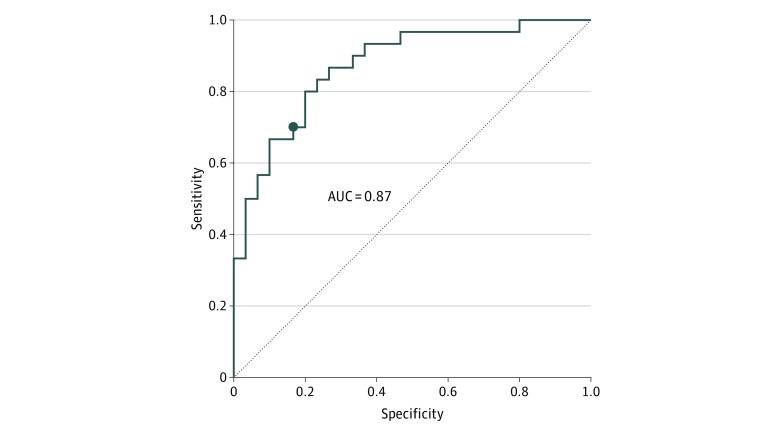
Receiver Operating Characteristic Curve Showing Classification Model PerformanceModel quality is demonstrated by the area under the curve (AUC). Based on Youden index, the optimal model (marked by dot) differentiates major depressive disorder from healthy control with 77% accuracy (70% sensitivity and 83% specificity).